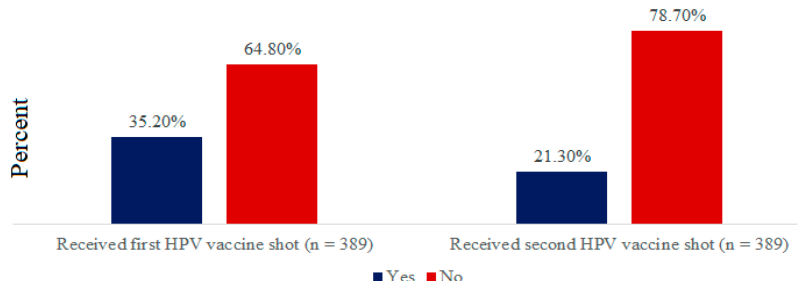
Figure 1. Uptake of the first and second dose of HPV vaccine. Table 1. Characteristics of HPV-2 uptake